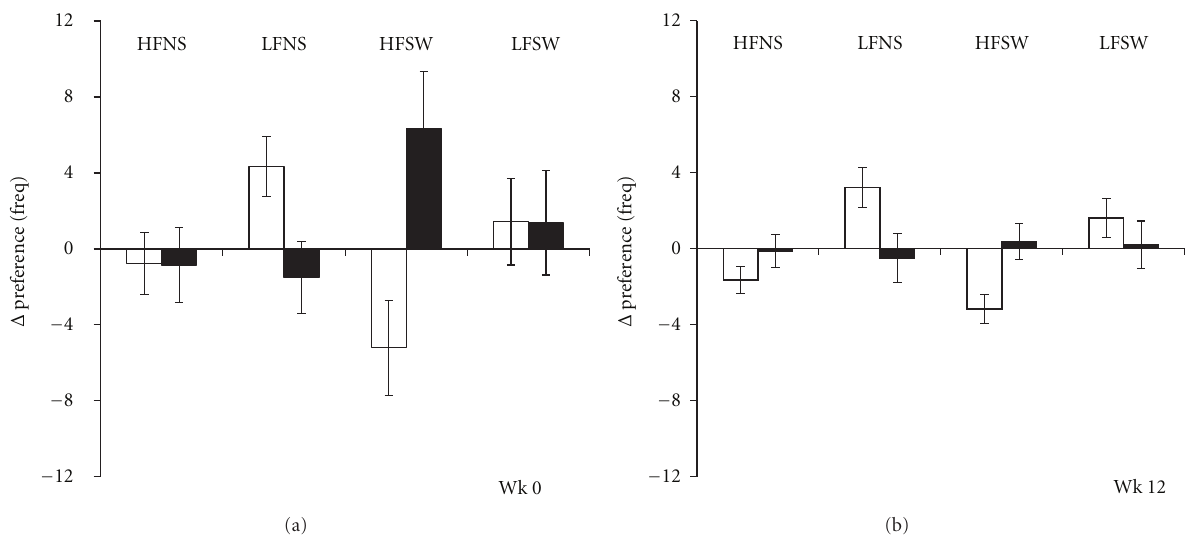
Figure 4: Acute changes in relative preference for food categories measured before and after a single bout of exercise in Responders ( (cid:2) ) and Nonresponders ( (cid:3) ). HF: high fat, LF: low fat, NS: non-sweet, SW: sweet.